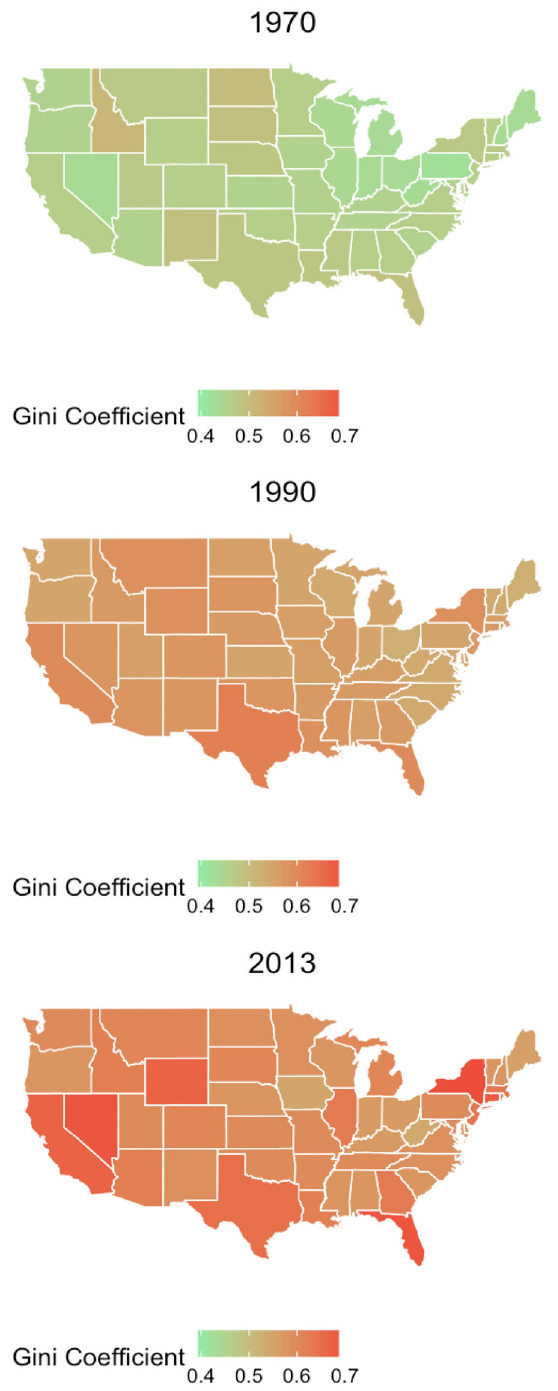
Fig. 1 Gini coefficient maps of the United States by state for three selected years. Data source The U.S. Income Inequality Page of Mark W. Frank (2015),